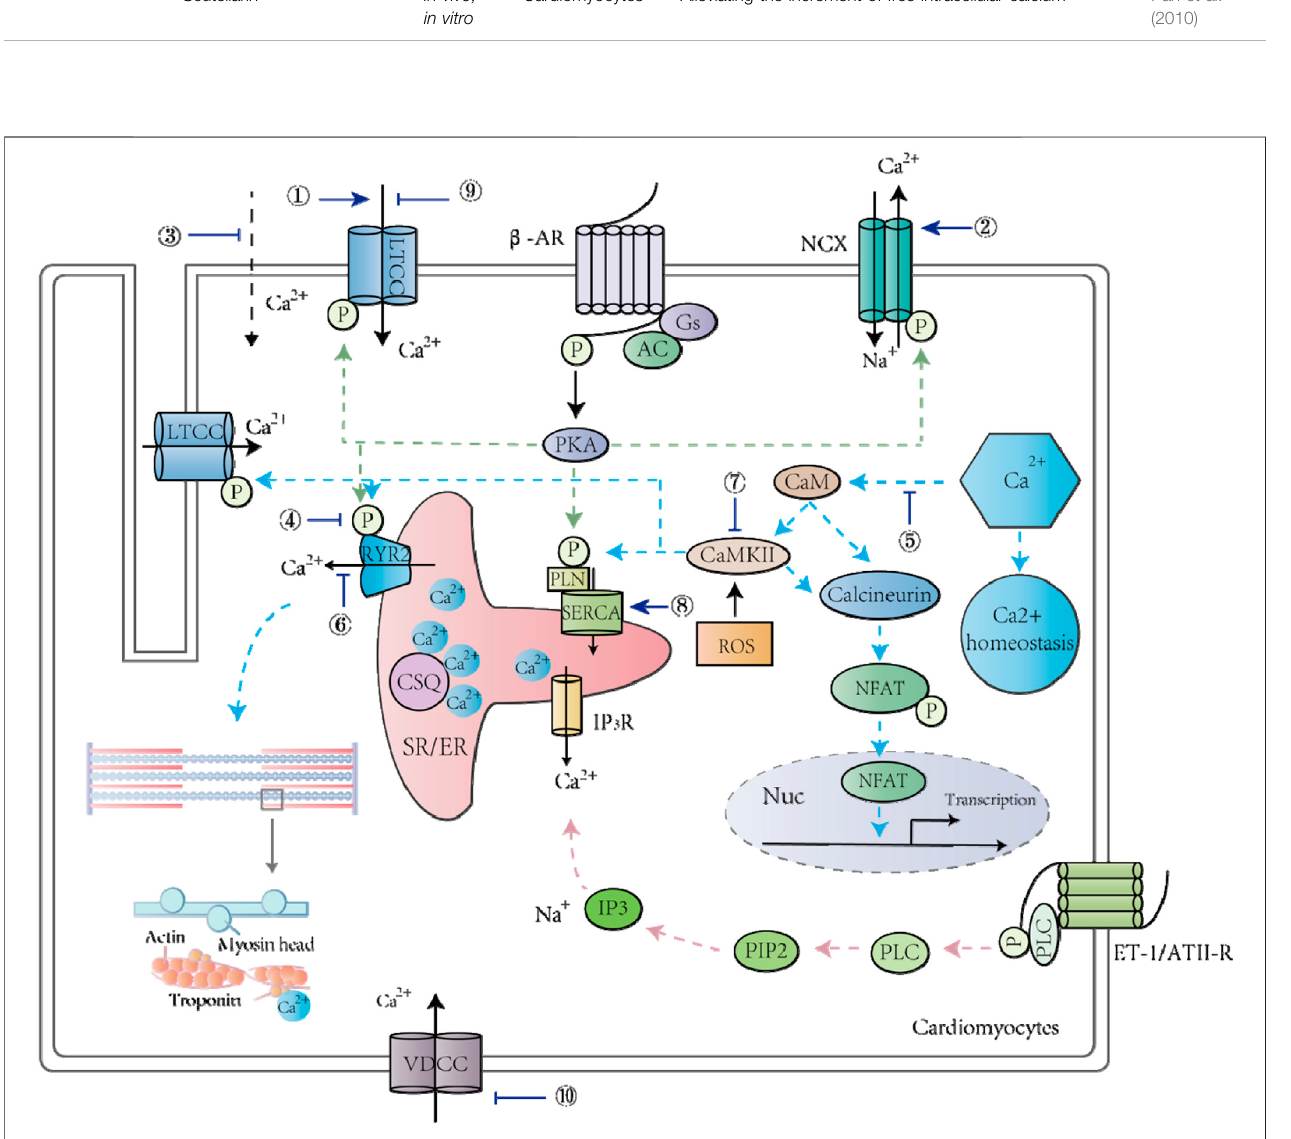
Frontiers in Pharmacology |